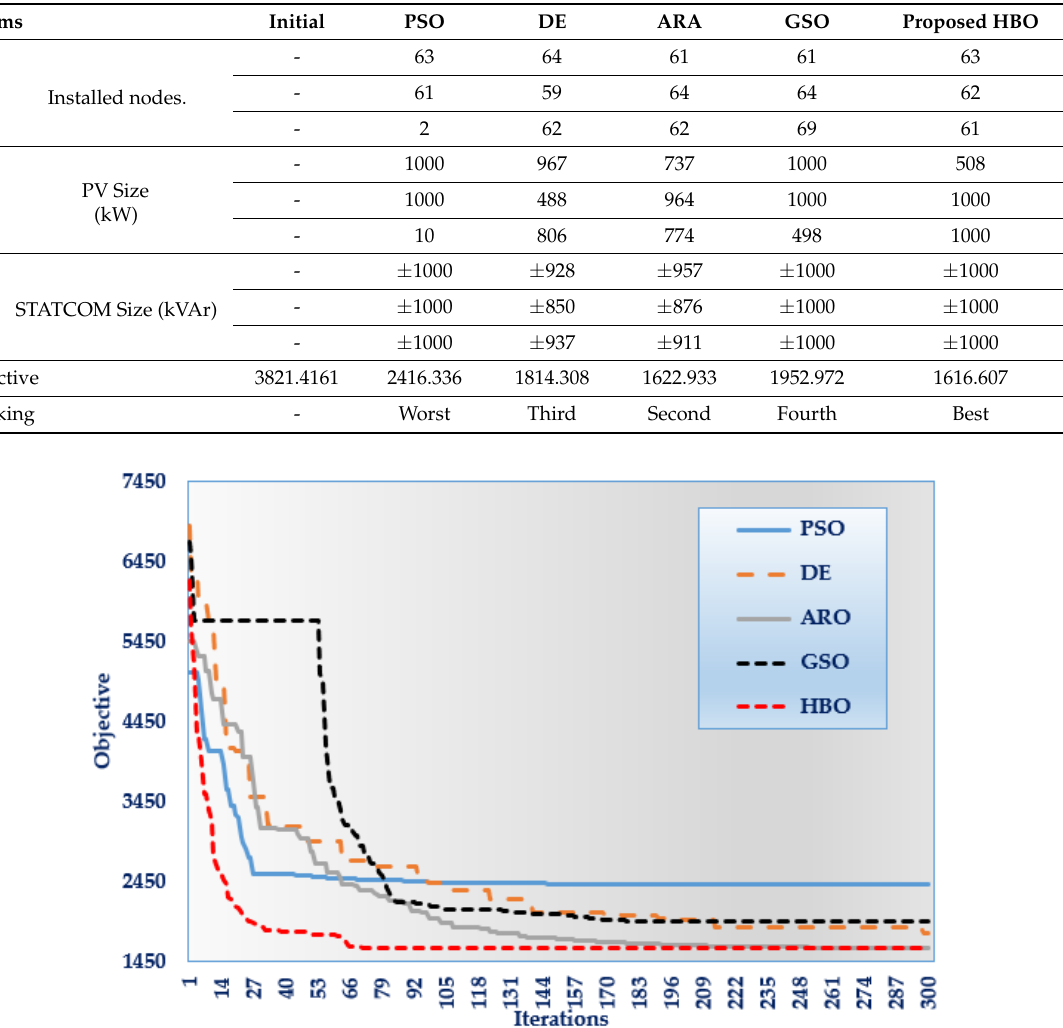
Table 3. PV-STATCOM allocations for IEEE 69-distribution feeder.